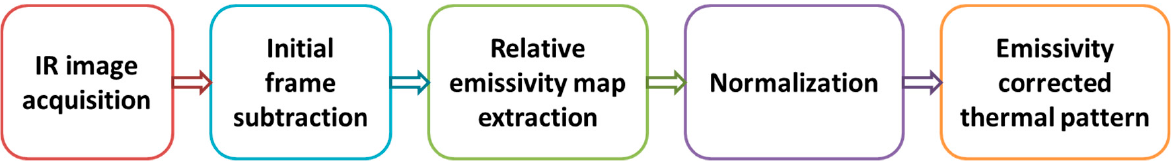
Figure 2. Flow chart of thermal pattern emissivity correction.